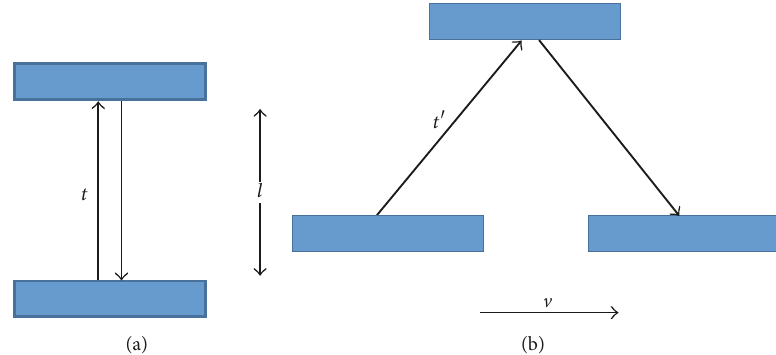
Figure 1: Light clock: (a) at rest and (b) in motion perpendicular to the clock’s axis.